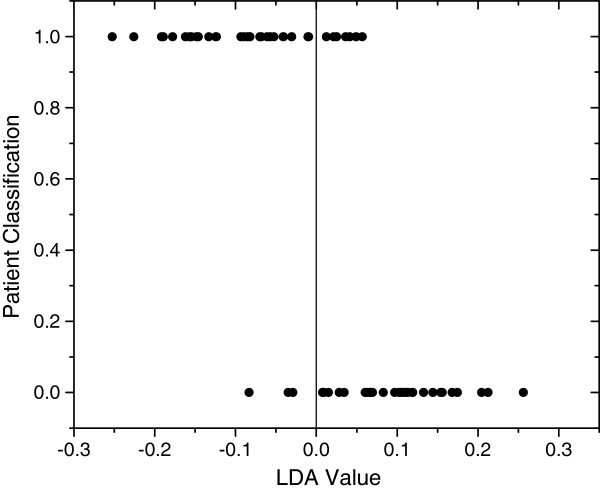
One dimensional SIR plot showing classification of dogs into groups based on CLPDP. The vertical line separates the two groups based on the measured multidimensional characteristic (i.e., CLPDP). A linear discriminant analysis (LDA) value generated for each dog ranks the individual within the group relative to the vertical line. Individual dogs are represented as dots. The dogs represented by the dots that are at the bottom of the graph are the Miniature Schnauzers of group 2A. Their lipoprotein profiles plot them all to the right of the vertical line, with the exception of 3 dogs (90% of dogs classified correctly). The dogs represented by the dots at the top of the graph are the dogs of other breeds (group 1). Twenty-eight of the 35 dogs (80%) were classified as a separate group to the left of the vertical line. Seven of the 35 dogs were classified to the right of the vertical line together with the Miniature Schnauzers.